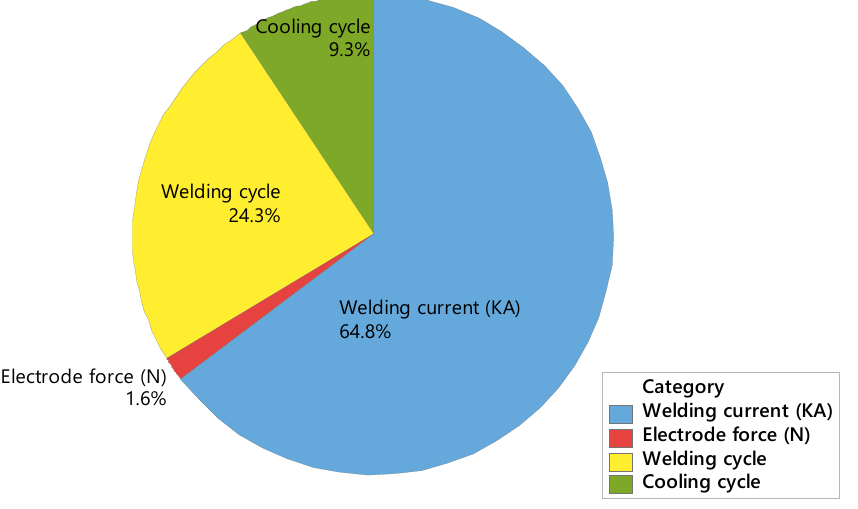
Figure 16. The diagram of effectiveness of input parameters on TSS of RSW joints.